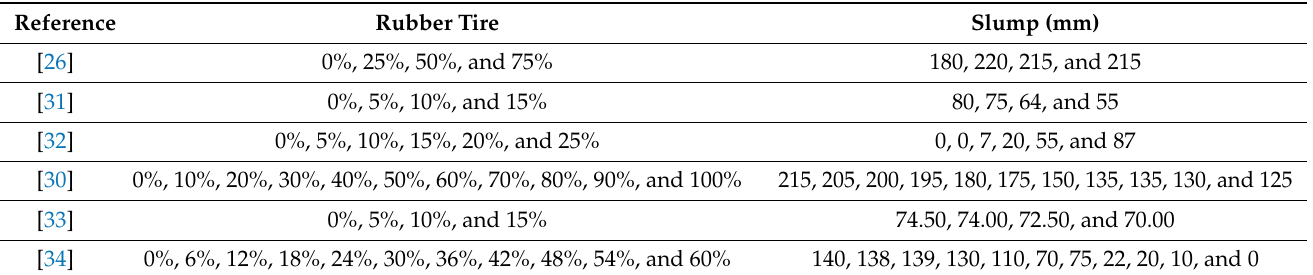
Table 1. Summary of slump flow.